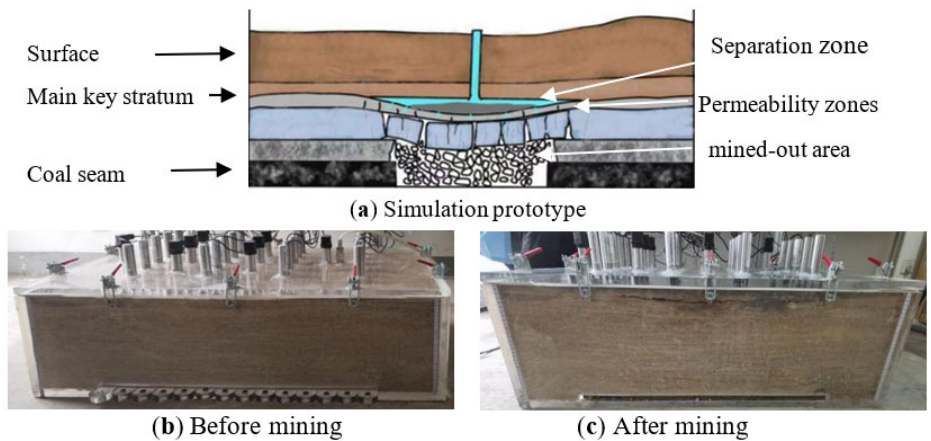
Figure 10. Similar simulation of mining bed separation grouting.